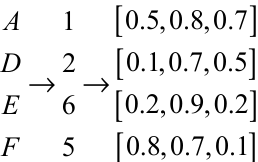
Figure 1. the process to auto-embed a peptide sequence to a matrix. Figure 1. The process to auto-embed a peptide sequence to a